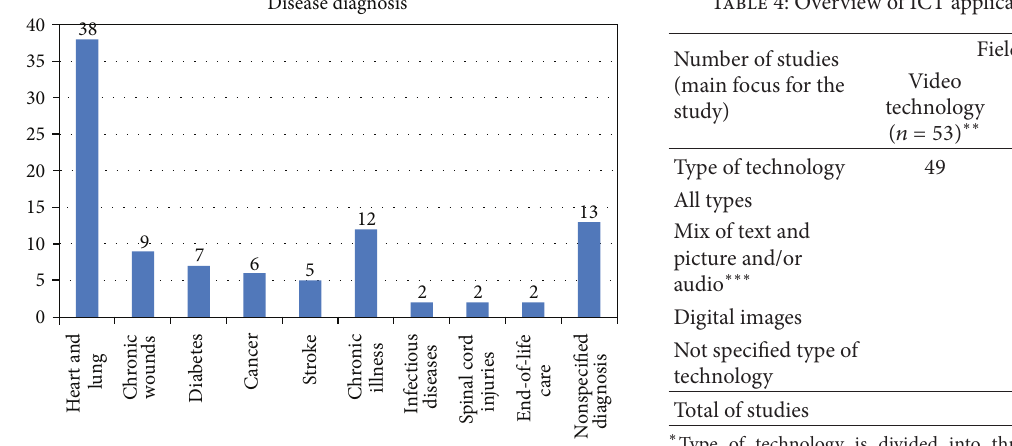
studies did not specify the used ICT application (Table 4).